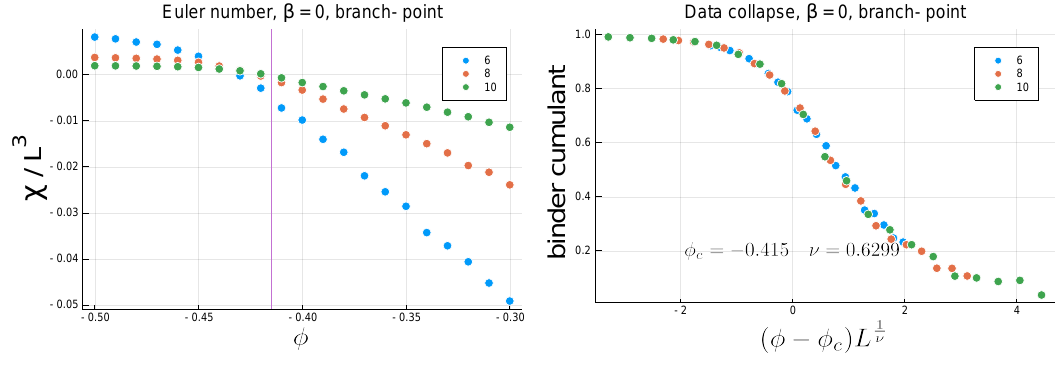
Figure 11: Scans varying φ while holding β = 0 at various system sizes, using branch point vertex resolution protocol. Left column: Average euler character per domain wall component per unit volume, 〈 χ 〉 / L 3 . Right column: Binder cumulant as a func- ) L 1 ν tion of scaling variable ( φ − φ c